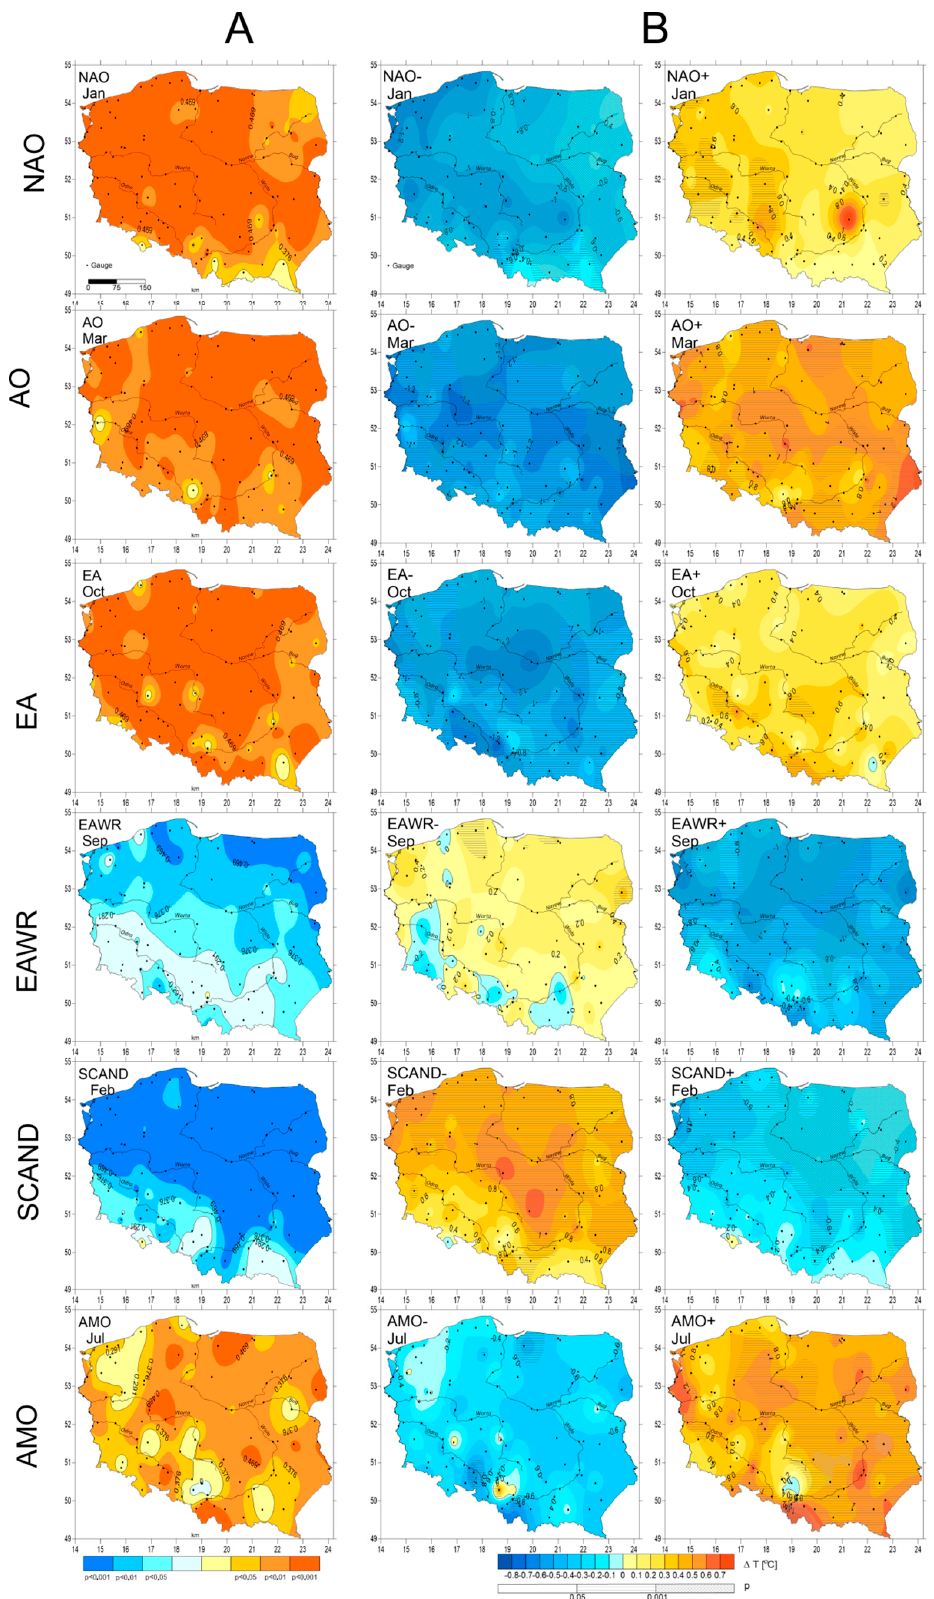
Figure A2. Spatial distribution of coefficients of correlation of monthly water temperature values with indices of macroscale circulation types ( A ) and deviations of monthly temperature values ( Δ T) in various phases thereof from average values for the years 1971–2015 and their statistical significance (p)—( B ).